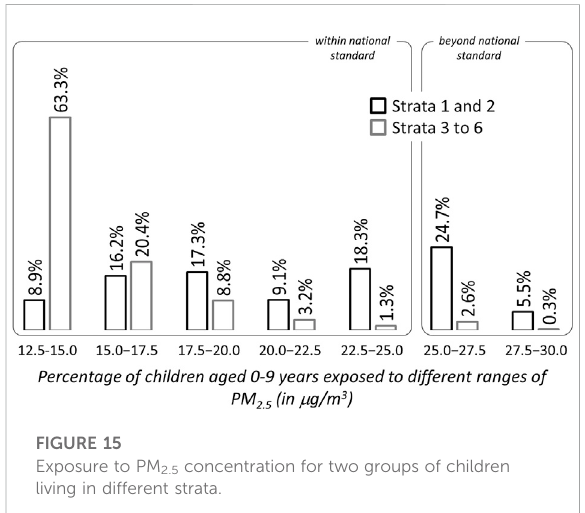
FIGURE 15 Exposure to PM 2.5 concentration for two groups of children living in different